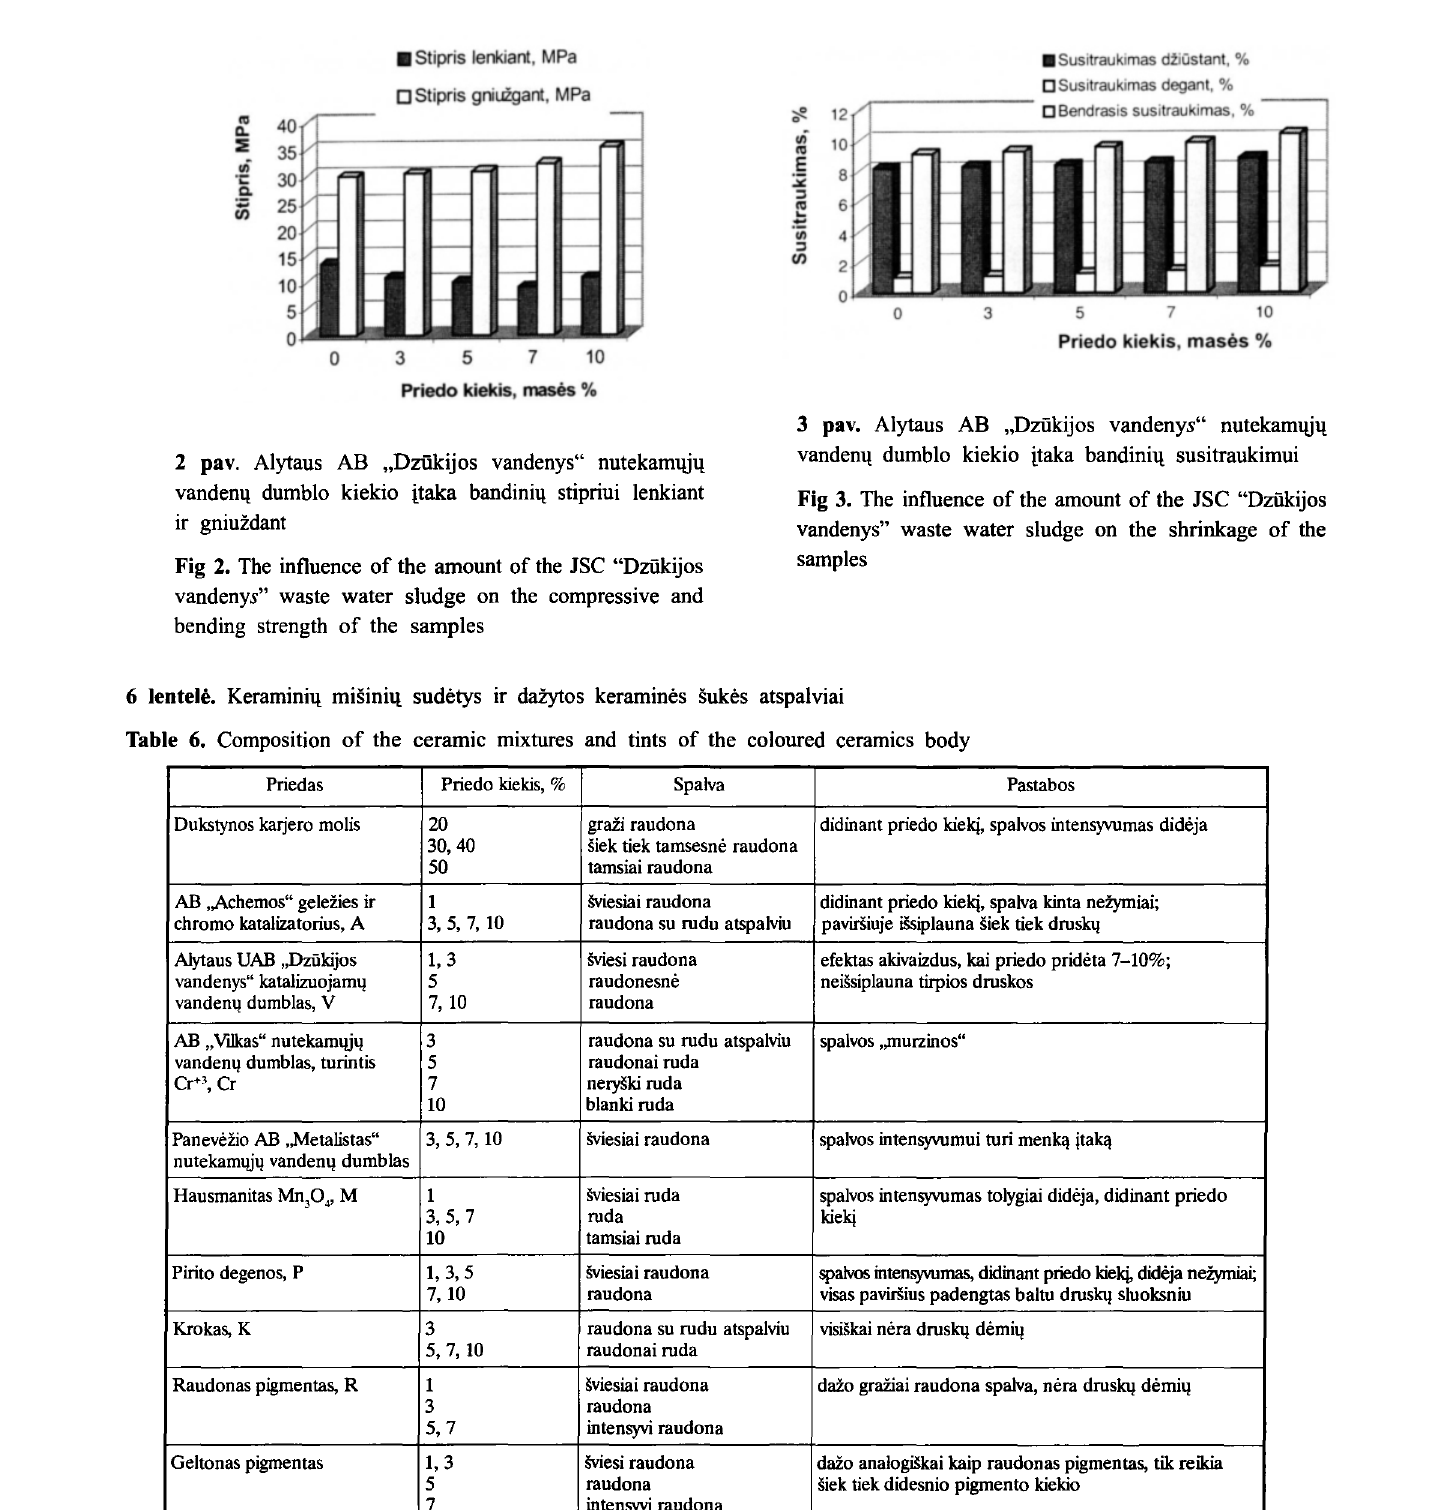
Fig 3. The influence of the amount of the JSC "Dziikijos vandenys" waste water sludge on the shrinkage of the samples